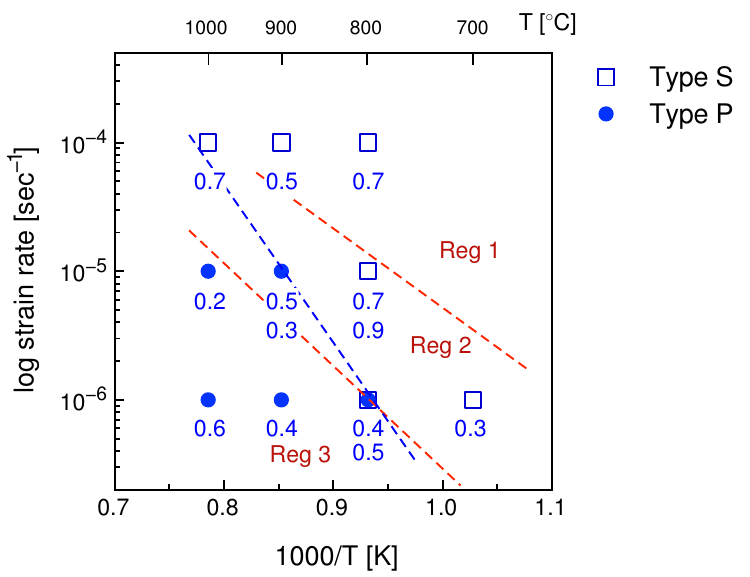
Figure 1. Summery of deformation experiments of agate conducted by Masuda and Fujimura [4]. Numbers indicate the differential stress (in GPa) at 10% strain. The blue dashed line shows the boundary between Type-S and Type-P microstructures. Red dashed lines show the dislocation creep regime boundaries for samples of quartzite with water added defined by Hirth and Tullis